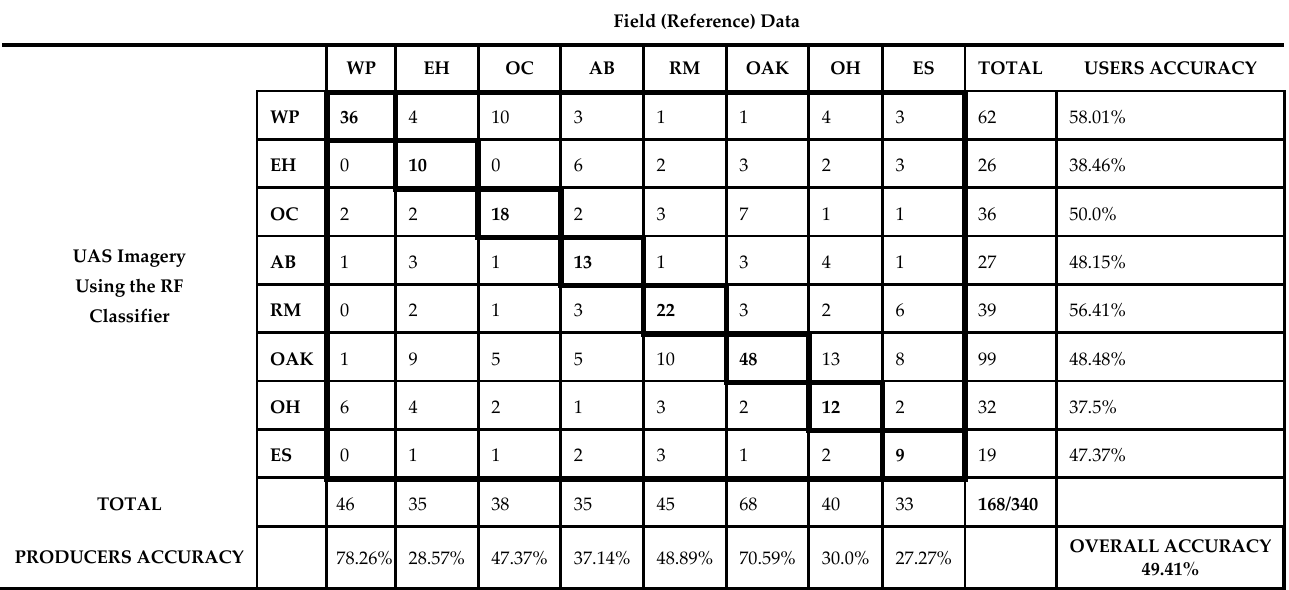
Table A4. Thematic map accuracy assessment error matrix for individual trees using the UAS imagery and the RF algorithm for eight classes.